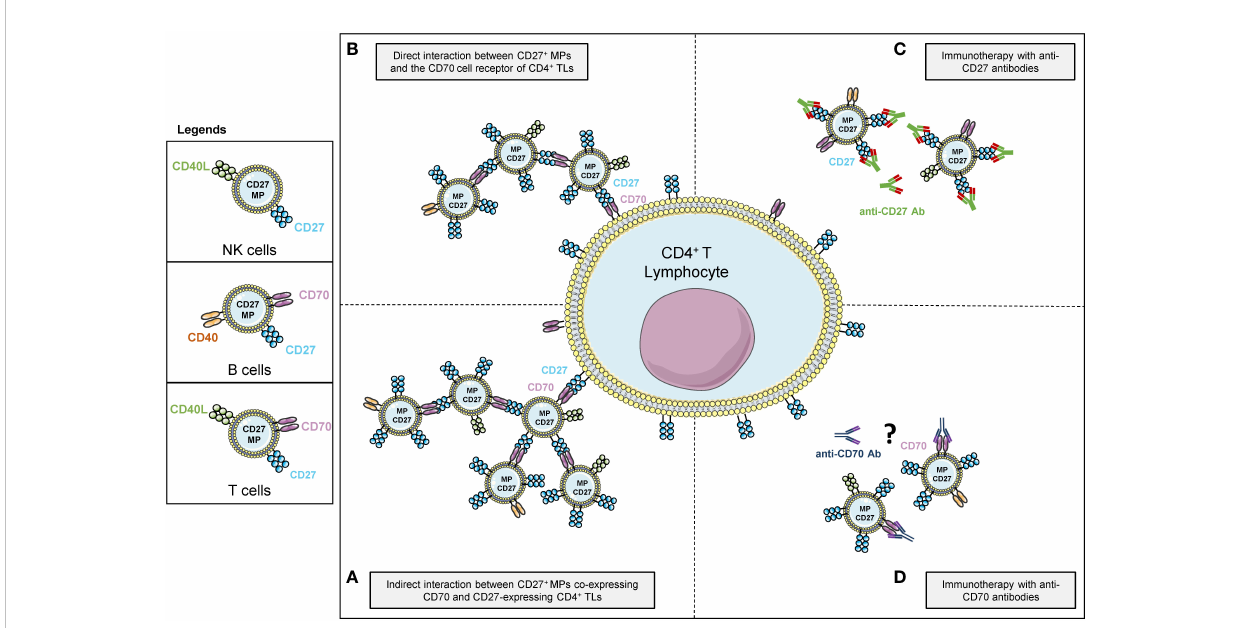
FIGURE 7 Schematic representation of the mechanism of action of vesicular forms of CD27 of different cellular origins against CD4 + TLs (A) Mode of agglutination attachment of MPs to CD4 + TLs via the binding of cellular CD27 and vesicular CD70 receptors. (B) Mode of agglutination attachment of CD27 + MPs to CD4 + TLs via the binding of cellular CD70 and vesicular CD27 receptors. (C) Effect of competition between CD27 + MPs and CD4 + TLs for binding to monoclonal anti-CD27 antibodies. (D) Hypothesis concerning the effect of monoclonal anti-CD70 antibodies on the interaction between CD27 + MPs and CD4 +